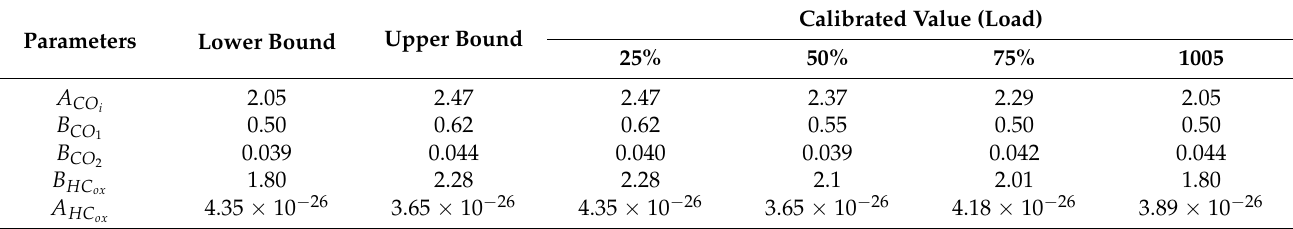
Table 4. Calibration results of primary parameter of